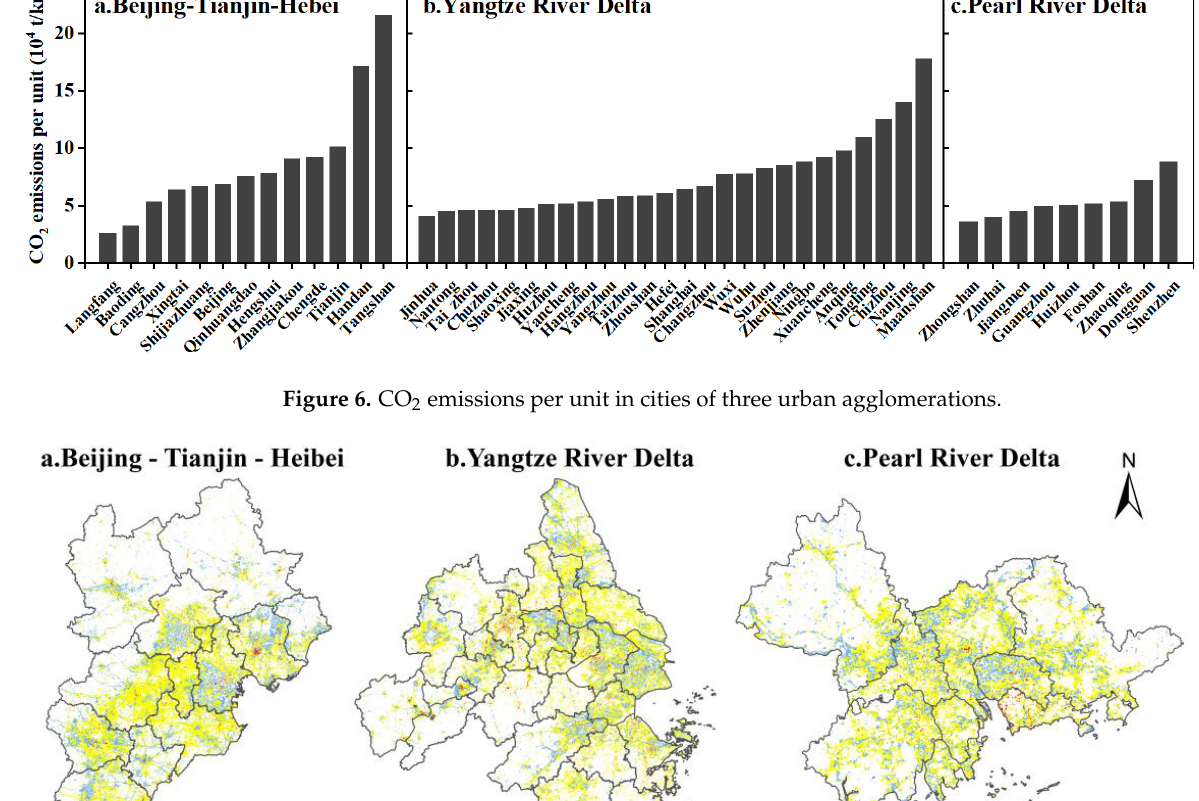
Figure 6. CO 2 emissions per unit in cities of three urban agglomerations.